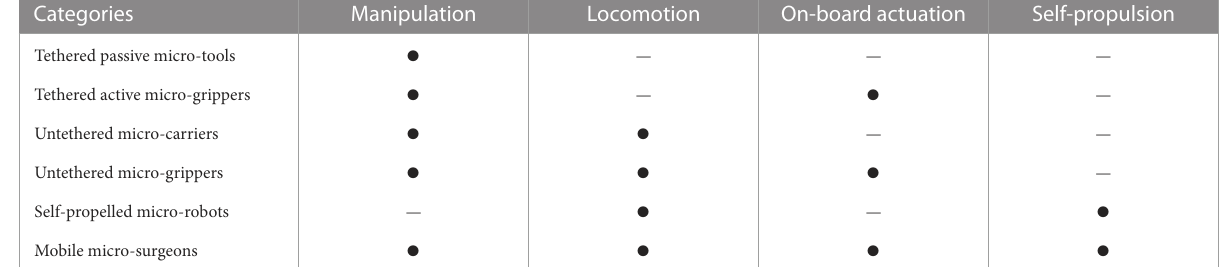
TABLE1 Functionalitiesofthesixmajorcategoriesofmicro-robots. Categories